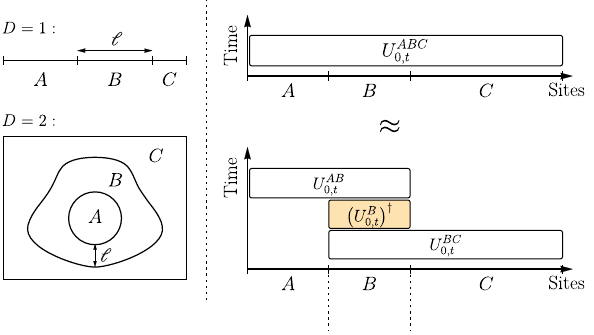
FIG. 1. A demonstration of the unitary decomposition in Lemma 1. (a) The three disjoint regions A , B , C in D ¼ 1 and D ¼ 2 dimensions with A convex and compact. (b) Lemma 1 allows the evolution of the whole system to be approximated by a series of three evolutions of subsystems. The horizontal axis lists the sites in each of the three sets A , B , C (not necessarily according to their geometrical arrangement, particularly in higher dimensions). Each box is an evolution for time t of a Hamiltonian supported on the sites the box covers. These evolutions can be forward (white fill) or backward (orange fill, with dagger) in